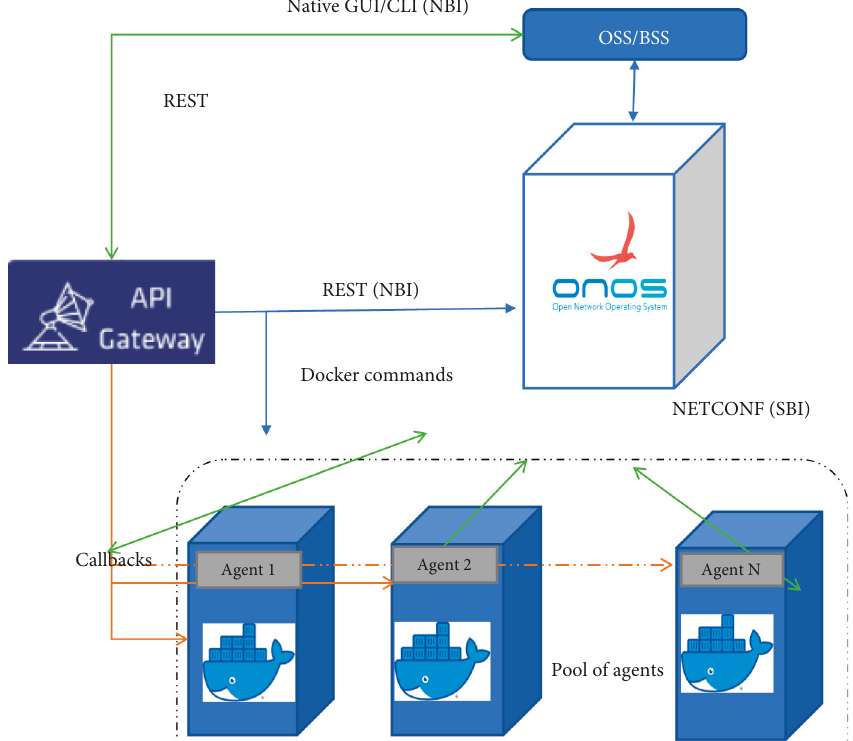
Figure 10: SDON architecture with automatic creation of